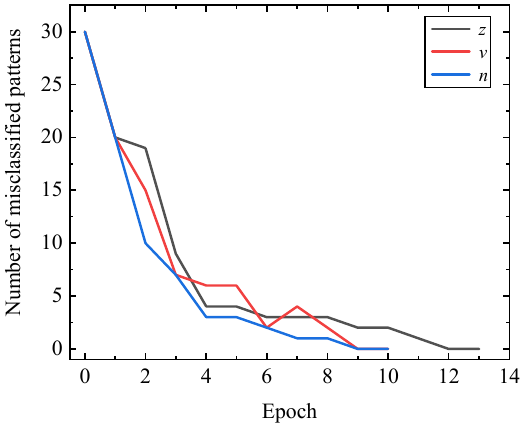
Figure 6. Relationship between the number of misclassifications and training time. After training the three subcircuits, the accuracy of the identification network circuit was verified. It could be deduced using Equation (10) that the weight change of the synaptic circuit at 0.01 ms was 6.25 × 10 − 5 ≈ 0, whose effect on the circuit could be ignored. Therefore, it was decided to sequentially input each verification picture at an interval of 0.01 ms. The verification process was divided into four stages, as shown in Table 3. Table 3. Various stages of verification.